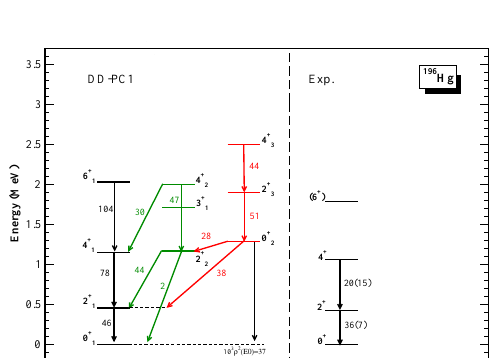
Figure 2: Low-lying level scheme of the even-even 196 Hg nucleus. The excitation energies, the B(E2) values (in −→ 0 + Weisskopf units) and the ρ 2 ( E 0; 0 + ) obtained with 2 1 the 5DCH based on the DD-PC1 functional are shown. The experimental data are taken from Ref.